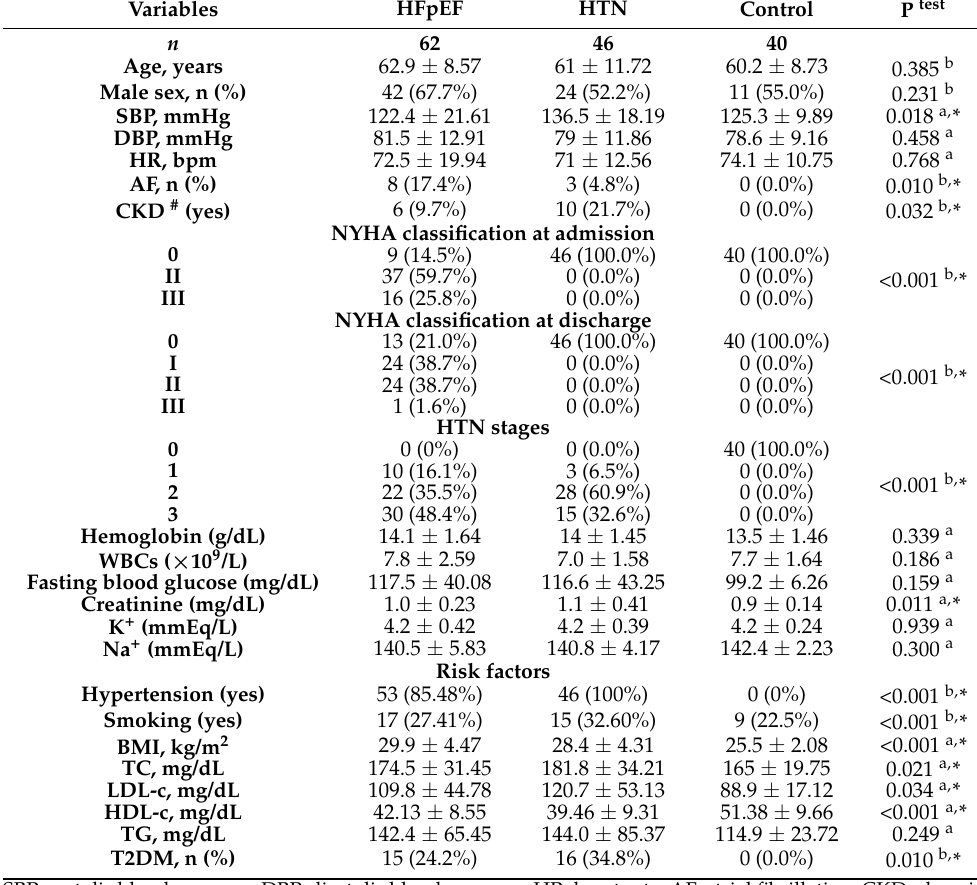
Table 1. Characteristics of all patients ( n =